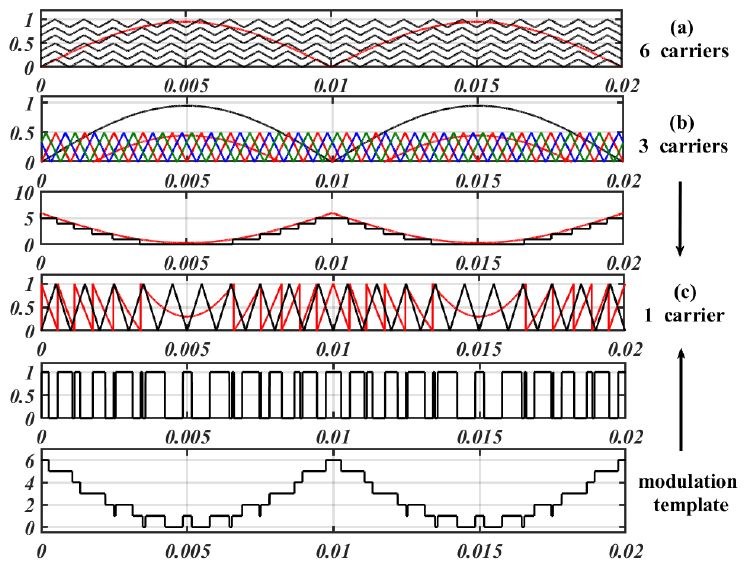
Figure 6. Conventional and proposed SPWM schemes. ( a ) IPD SPWM, ( b ) PS SPWM, ( c ) Proposed modulation procedure.